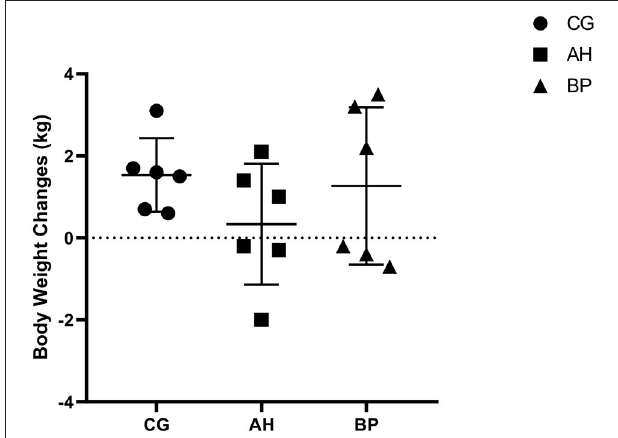
FIGURE 1 | The changes of body weight of goats before and after